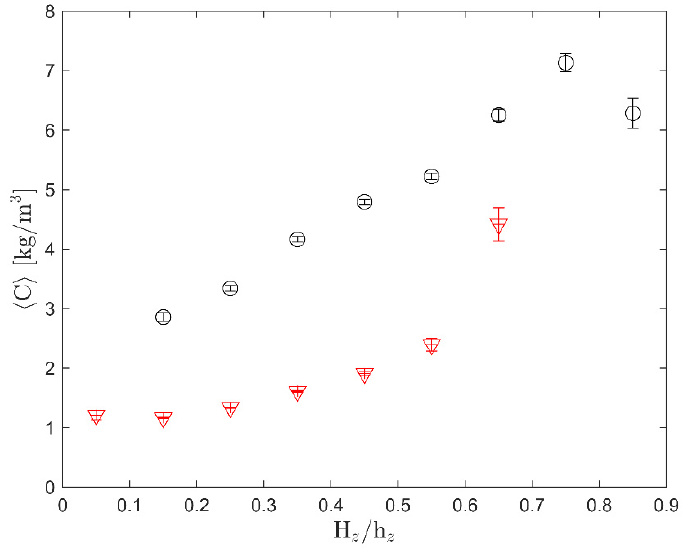
Figure 11. Near-bed suspended sediment concentration plotted against relative zero-crossing wave height. Black circles are data from Durras Beach (swell-wave dominated with mainly plunging breakers) and red triangles are data from Vejers beach (wind-wave dominated beach with mainly spilling breakers). The vertical bars show the standard error on the mean value within each γ -bin. From Christensen et al. [74].